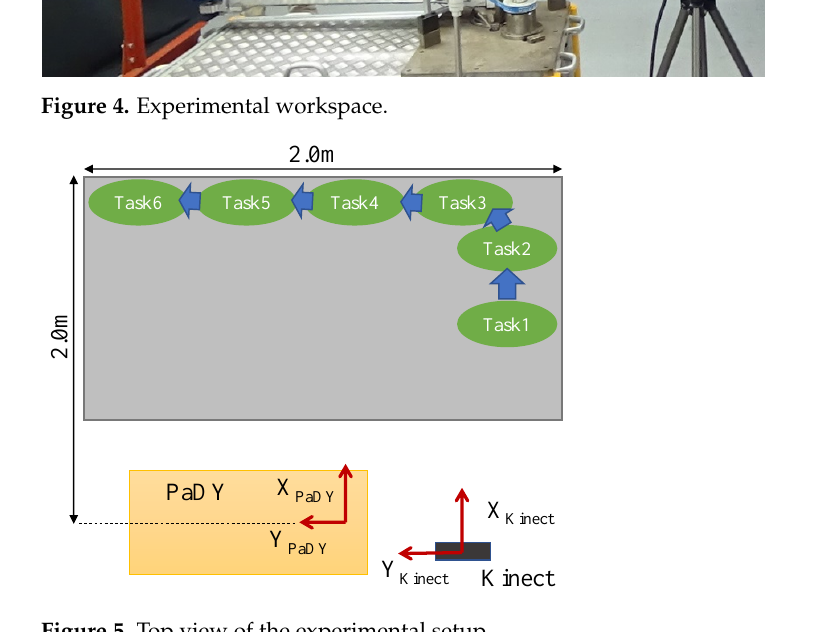
Figure 5. Top view of the experimental